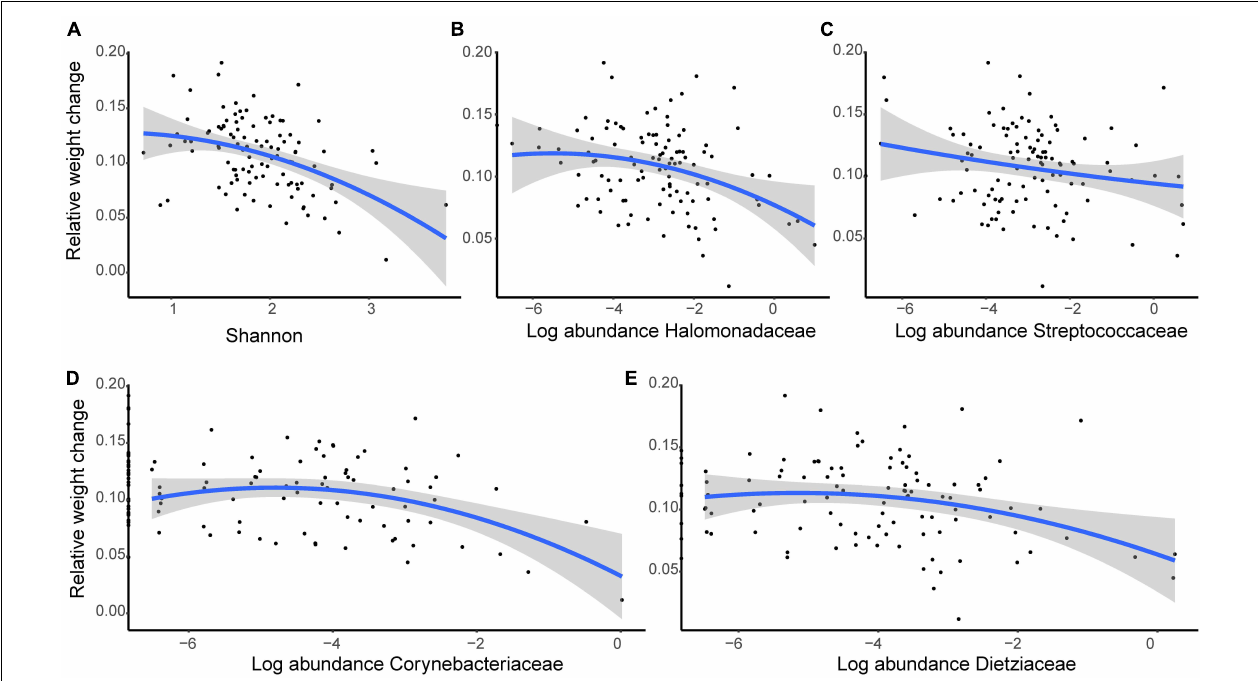
FIGURE 8 | The growth rate of young crested ibis is correlated with gut microbiota. (A) Shannon index. The normalized abundance of panel (B) Halomonadaceae, (C) Streptococcaceae, (D) Corynebacteriaceae, and (E) Dietziaceae. Relative weight change is measured as the weight change per day (W t + 1 –W t ) against weight at time t (W t ). Age and diet type at time t were considered a covariate, and individual ID was controlled as a random factor. The lines represent linear regression lines, while the shaded areas show the 95% confidence